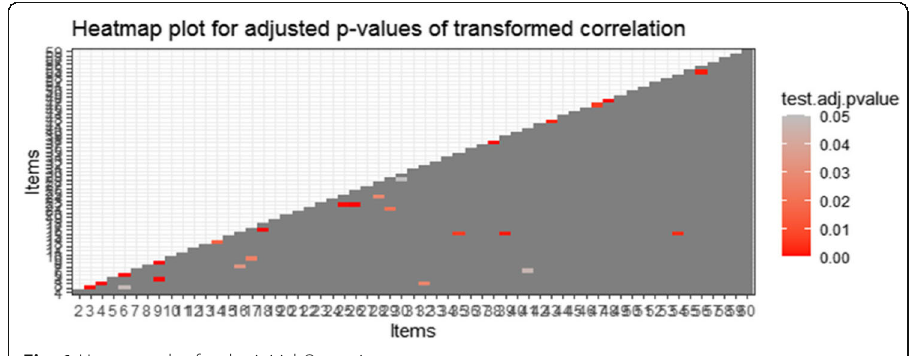
Fig. 1 Heatmap plot for the initial